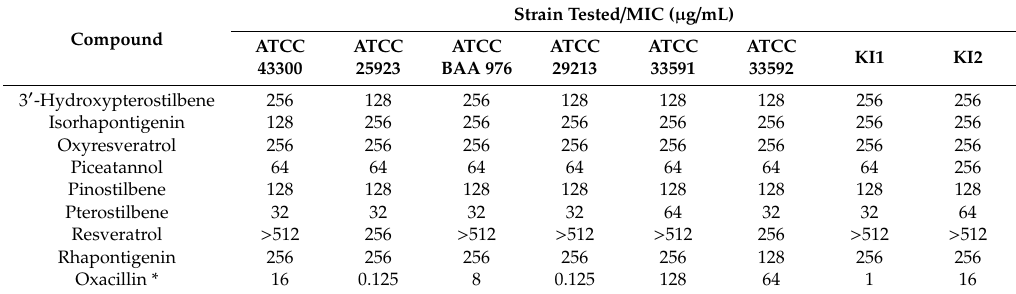
Table 1. In vitro growth-inhibitory e ff ect of stilbenoids against S. aureus from Zakova et al. (2018)